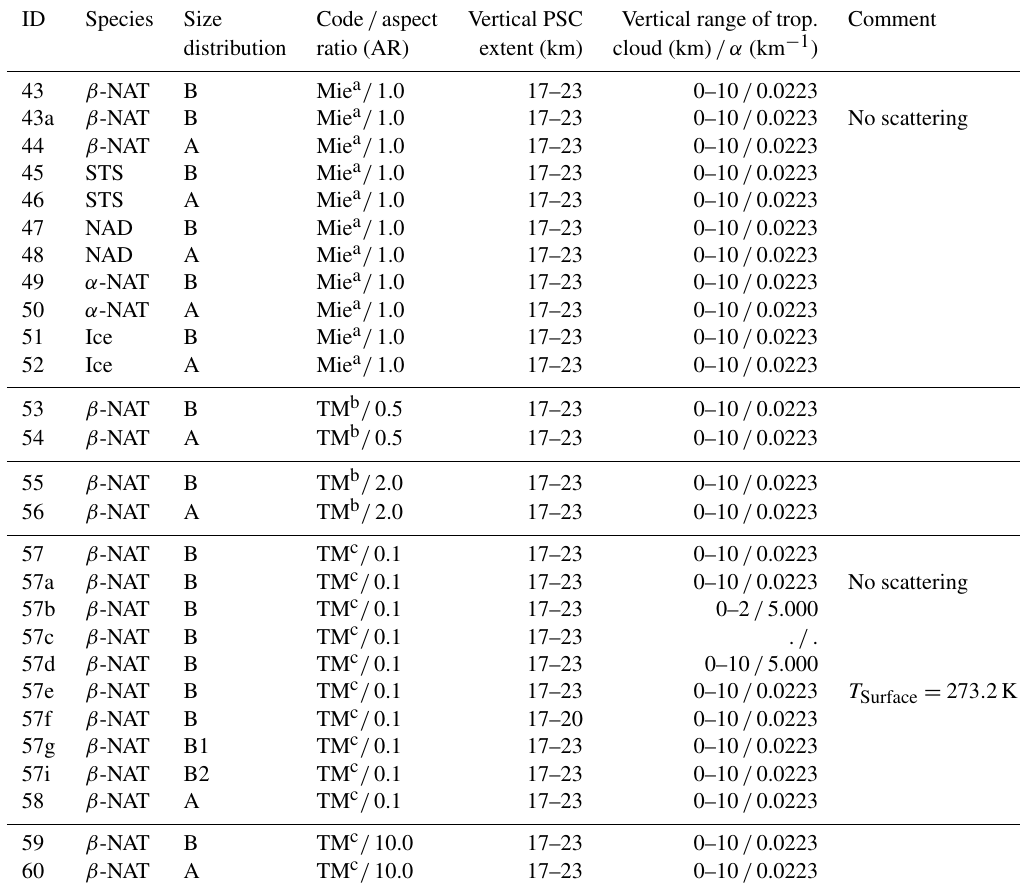
Table 1. Overview of radiative transfer scenarios.